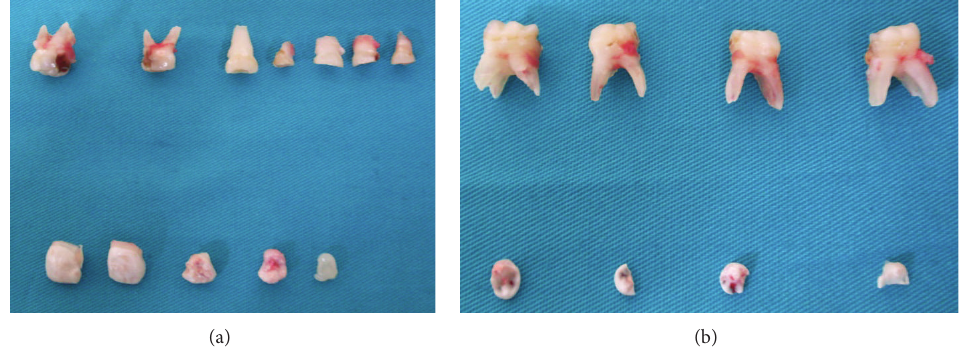
Figure 3: Postsurgical photographs showing extracted teeth. (a) Maxillary extracted primary molars and supernumerary teeth. (b) Mandibular extracted primary molars and supernumerary teeth.